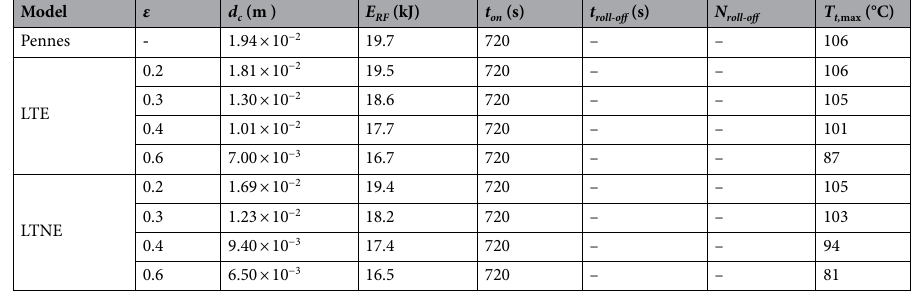
Table 1. 45 V RFA results computed for different bioheat models (Pennes’, Local Thermal Equilibrium, Local Thermal Non-Equilibrium) and porosity values. d c : coagulation diameter; E RF : applied RF energy; t on : total time generator is “on”; t roll-off : time of first roll-off; N roll-off : number of roll-offs.